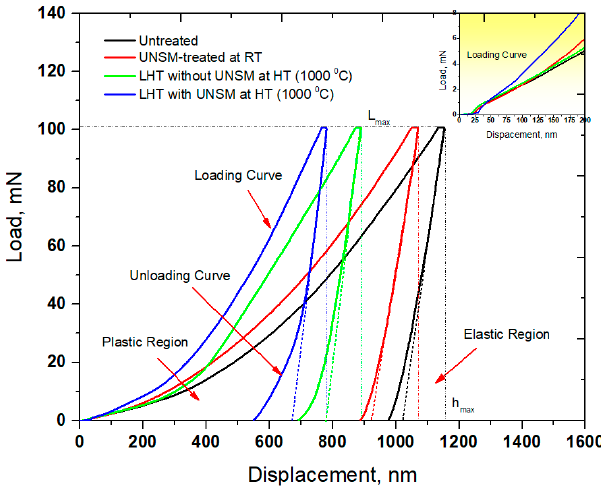
Figure 7. Comparison in load-displacement curve of the untreated, UNSM-treated at RT and LHT without and with UNSM treatment at 1000 °C specimens.